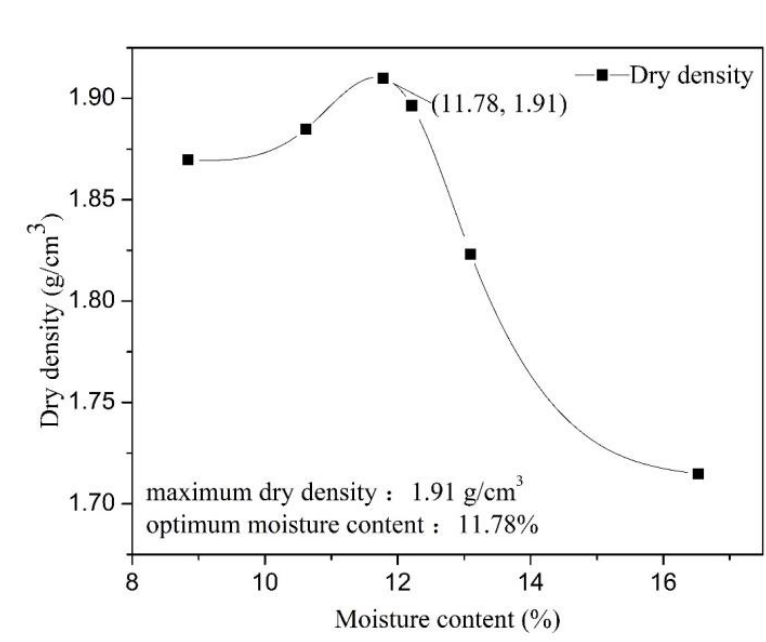
Figure 2. Compaction curve of undisturbed soil Table 1. Basic physical properties of undisturbed soil samples.